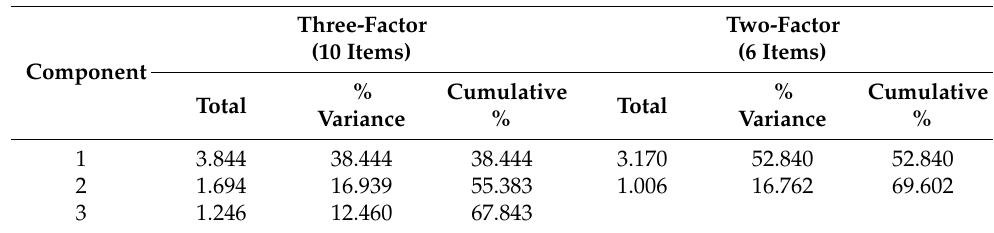
Table 4. Components extraction from data based on K1 criterion and total variance explained for FAS factor